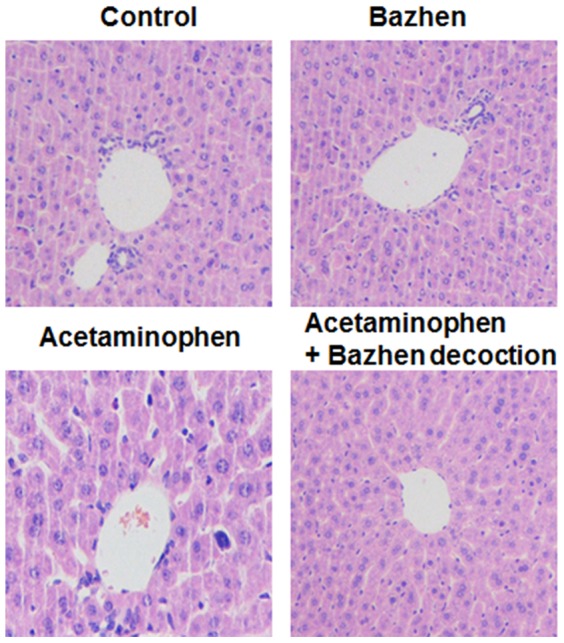
Effect of Bazhen decoction on acetaminophen-induced histopathological change in the liver tissue.Original magnifications were 200x.